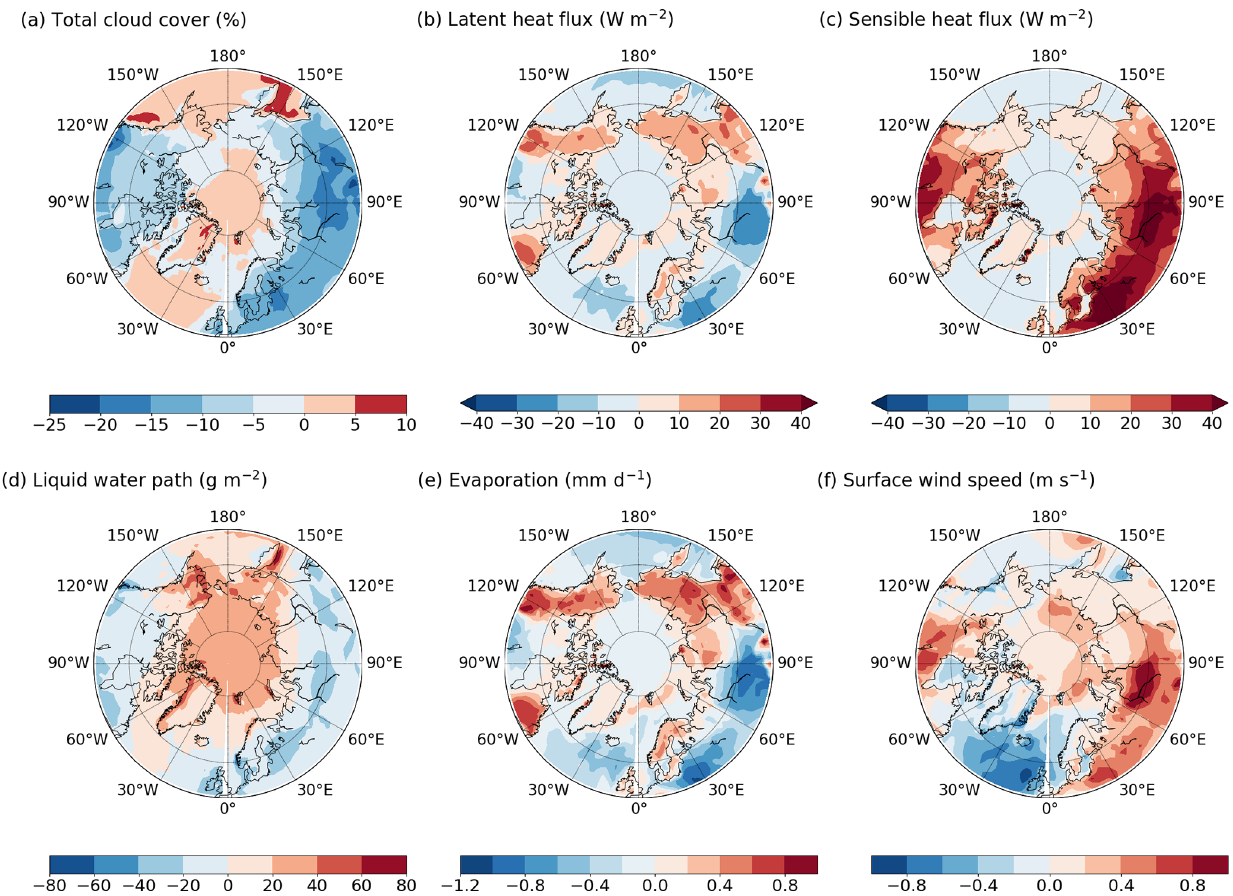
Figure 10. Summer LIG–PI anomalies of (a) total cloud cover (%), (b) latent heat flux (Wm − 2 ), (c) sensible heat flux (Wm − 2 ), (d) liquid water path (gm − 2 ), (e) evaporation (mmd − 1 ) and (f) surface wind speed (ms − 1